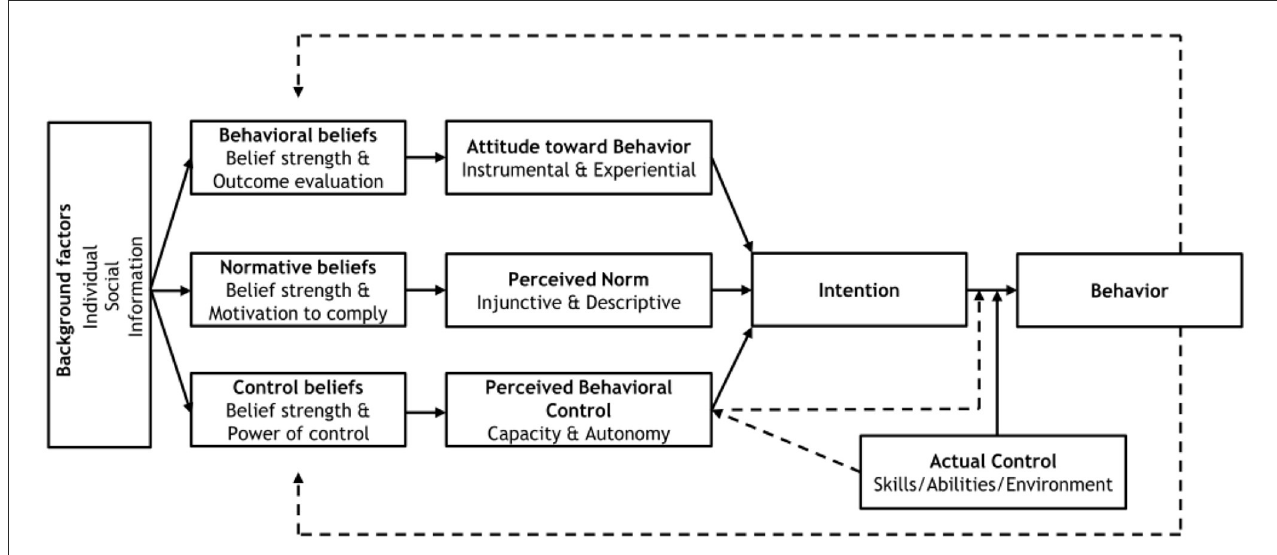
FIGURE1 Schematic presentation of the reasoned action approach (Peters, 2013, based on Fishbein and Ajzen,